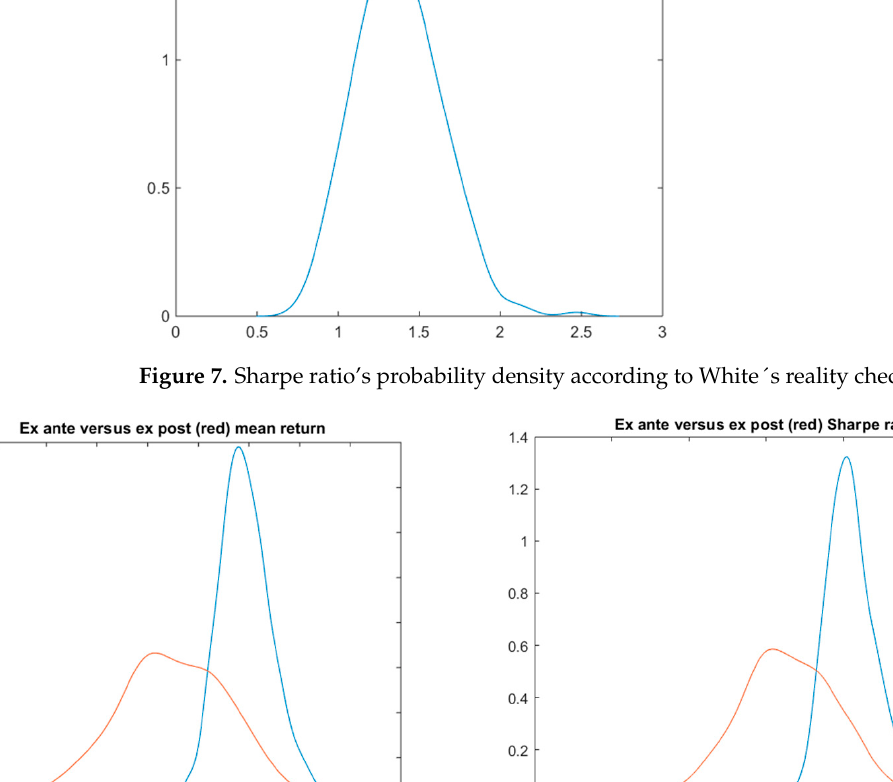
Table 1. Summary of the backtest overfitting tests’ results.